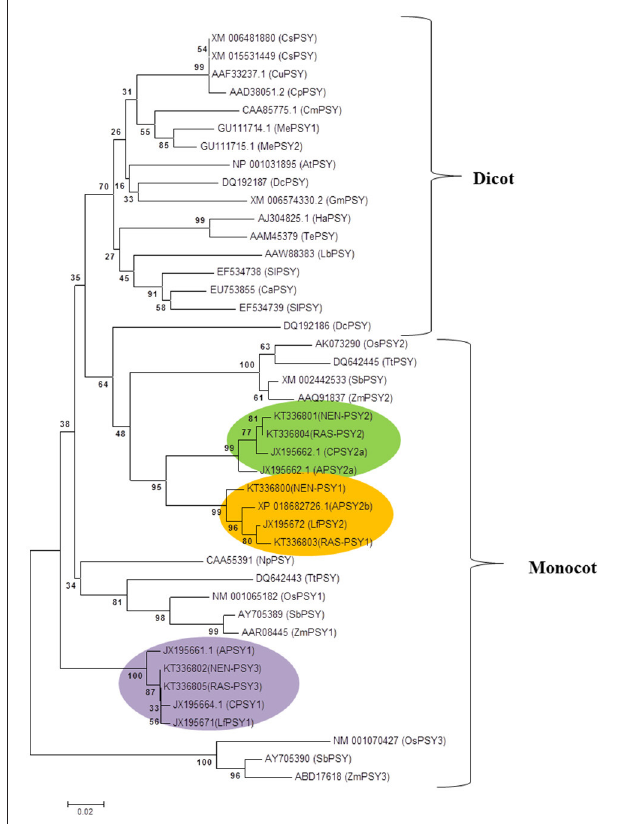
FIGURE 5 | Phylogenetic tree of PSY proteins. Neighbor joining based phylogenetic tree of the deduced PSY protein sequences of Nendran (NEN-PSY1 - 3) and Rasthali (RAS-PSY1 - 3) inferred with different plant species. The tree was bootstrapped to 10,000 trials, and bootstrapping values are shown at each node of the rooted rectangular cladogram. The GenBank accession numbers for different PSY sequences were given in the Supplementary Table S6